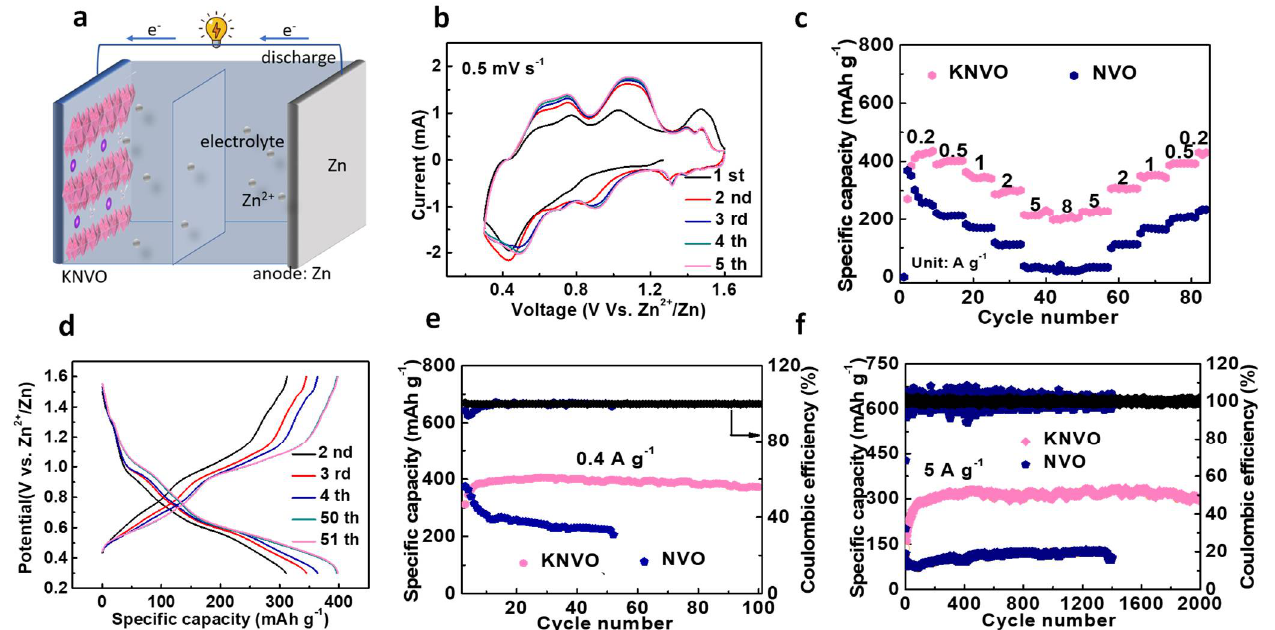
Figure 2. ( a ) Diagrammatic of the aqueous Zn//KNVO battery. ( b ) The first five cyclic voltammetry (CV) curves of KNVO at 0.5 mV s − 1 . ( c ) Rate performance at various currents ranging from 0.5 to 8 A g − 1 . ( d ) Charge/discharge profiles at 0.4 A g − 1 ; ( e ) Cyclic performance at 0.4 A g − 1 . ( f ) Cyclic performance at 5 A g − 1 .